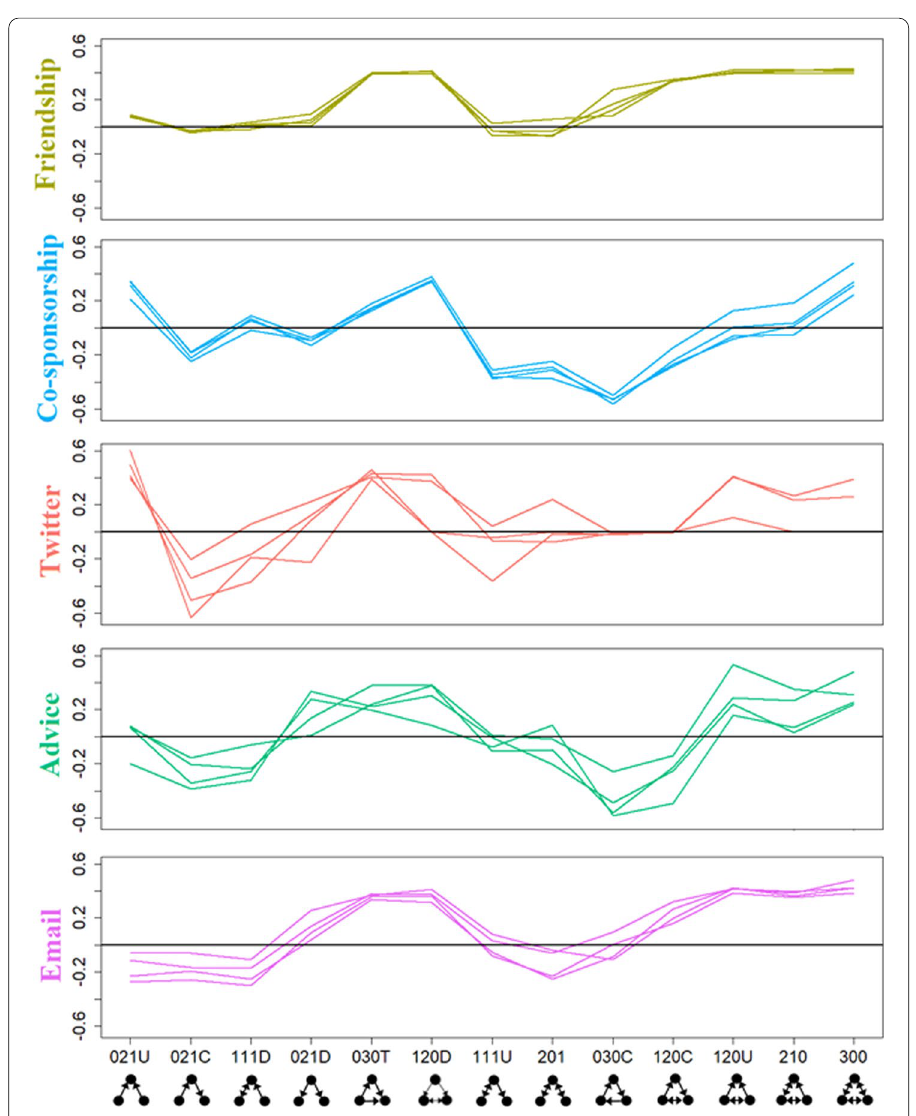
Fig. 4 Significance profiles for directed triads by network type. Range of y -axes refer to SRP i for triad of